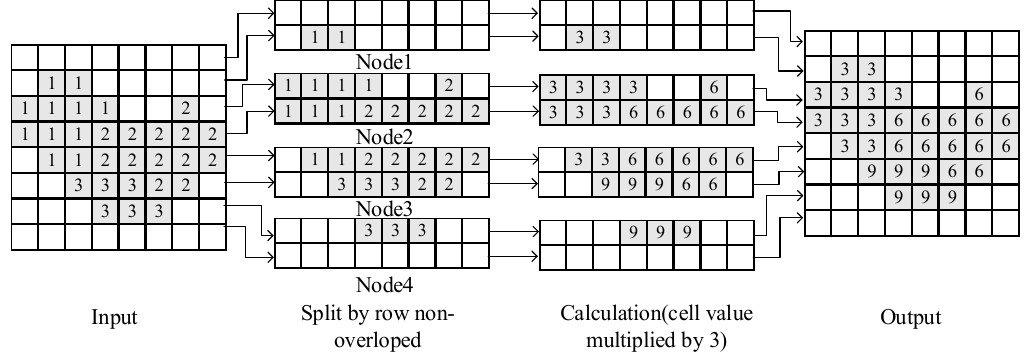
Figure 2. Data non-overlap splitting by row with 4 calculation nodes.